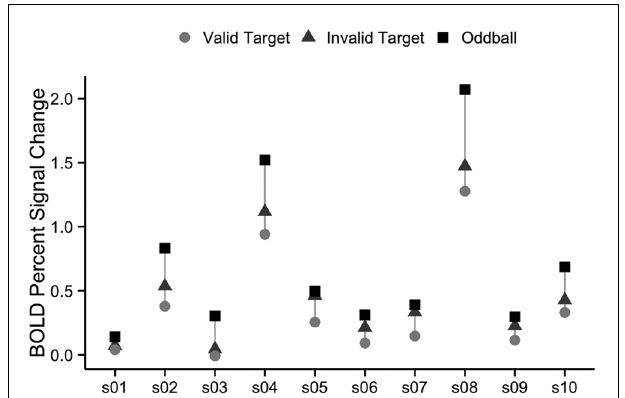
FIGURE 6 | Percent signal change in right TPJ STS for each individual subject, using group-defined ROI from the cueing task. The right TPJ STS ROI was defined using the group average contrast of invalid vs. valid, as shown, in Figure 2 . In every subject, oddball stimuli drive right TPJ STS more than invalid cues, even though invalid vs. valid cues were used to define the ROI. Subject labels are the same as Figure 2 . Each subject is represented by a vertical line, with percent signal change to valid targets shown with circles, invalid targets with triangles, and oddball images with squares.